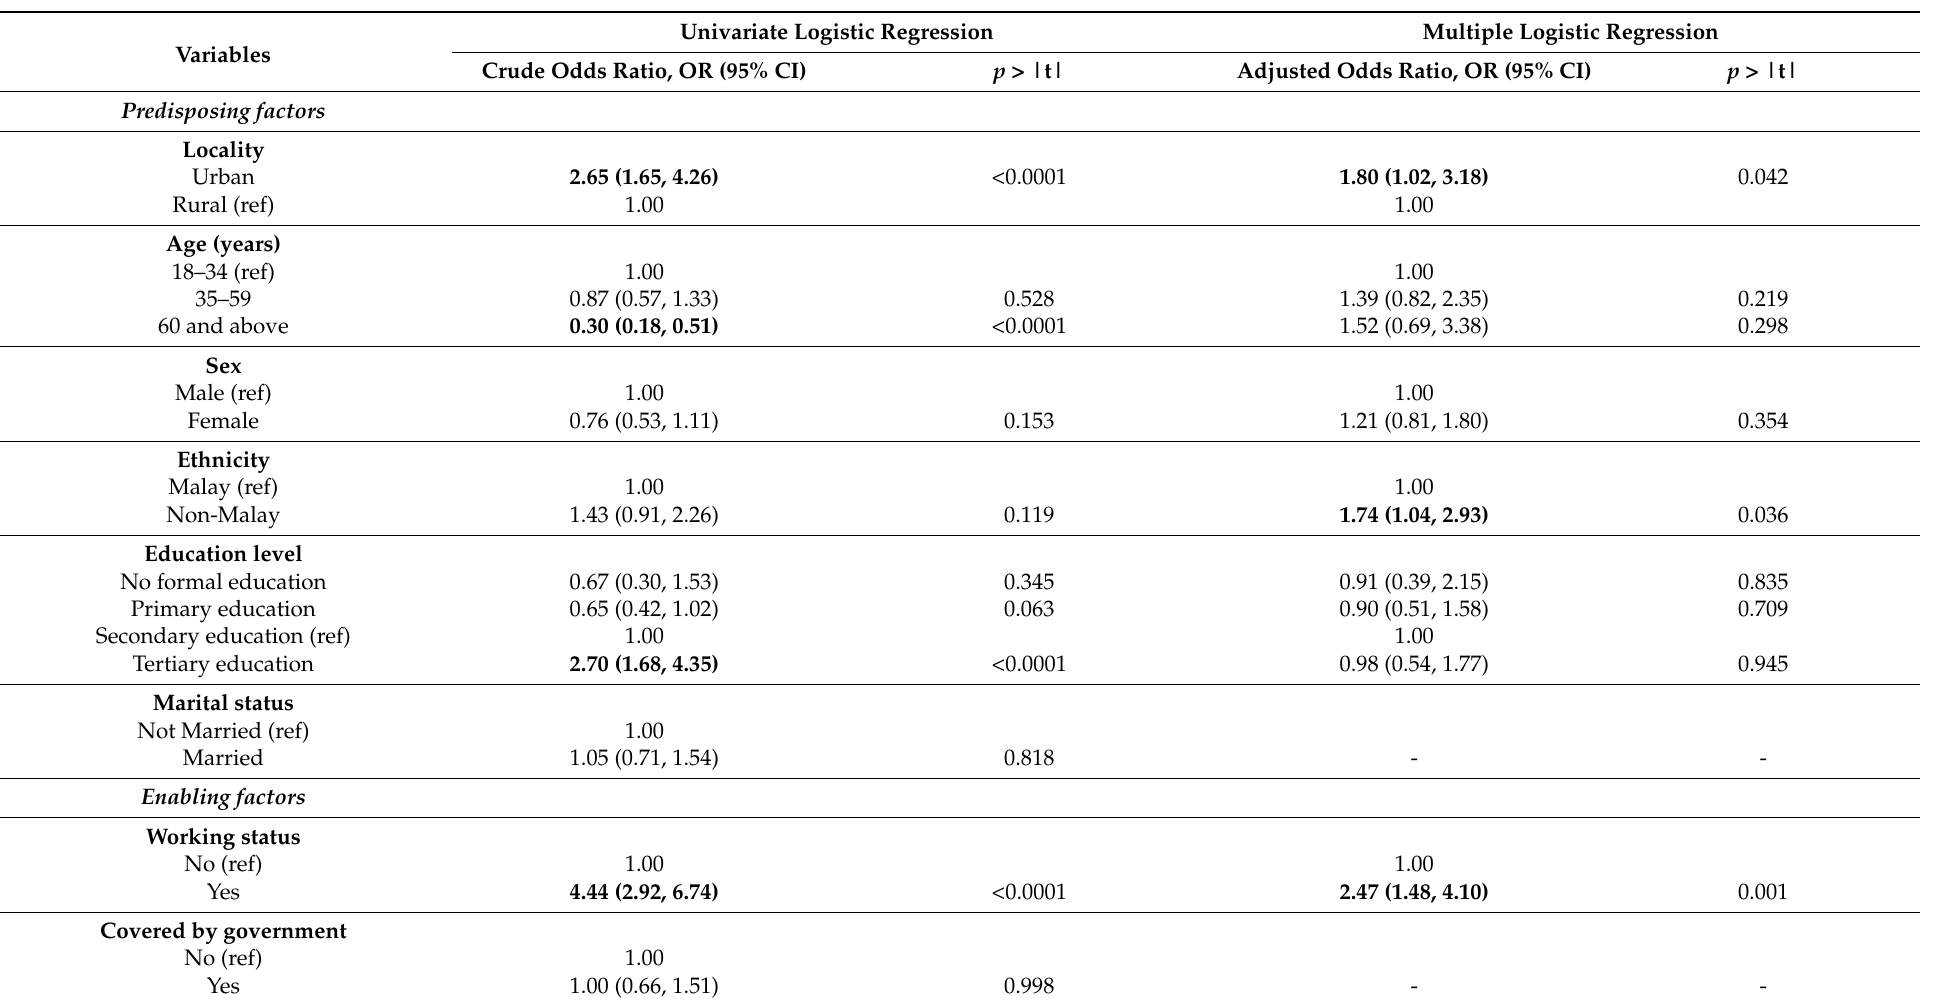
Table 4. Crude and adjusted ORs with 95% CIs for the utilisation of private outpatient services among those who utilised outpatient